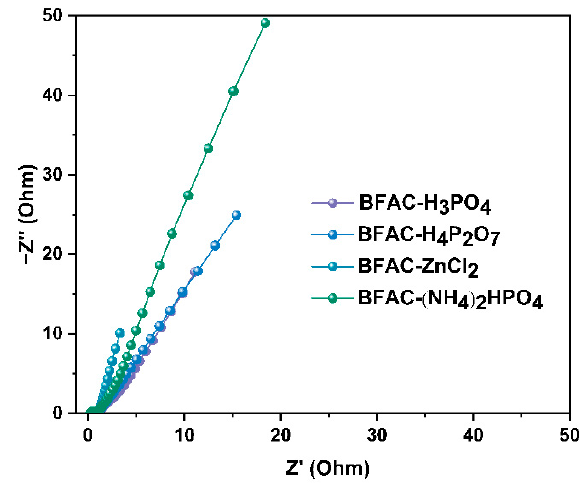
Figure 11. Electrochemical impedance spectroscopy of BFACs.